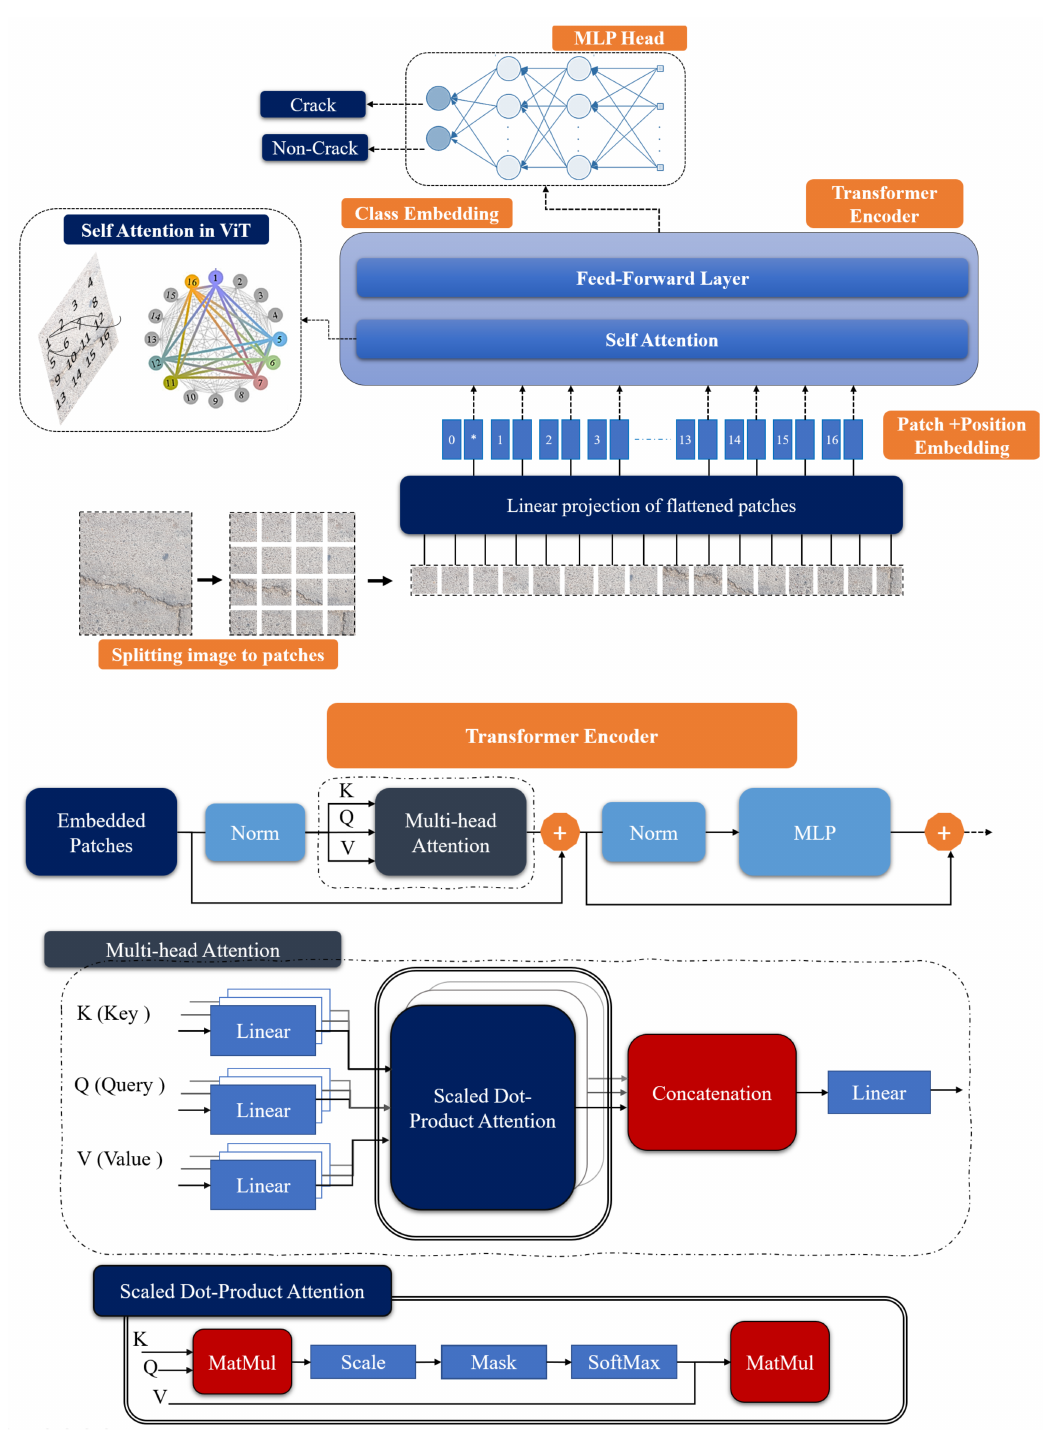
Figure 3. Vision-transformer architecture